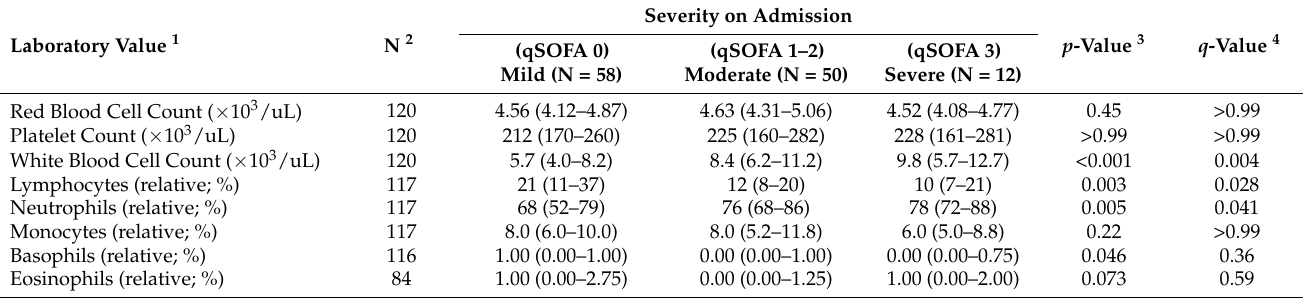
Table 3. Immunological features of COVID-19